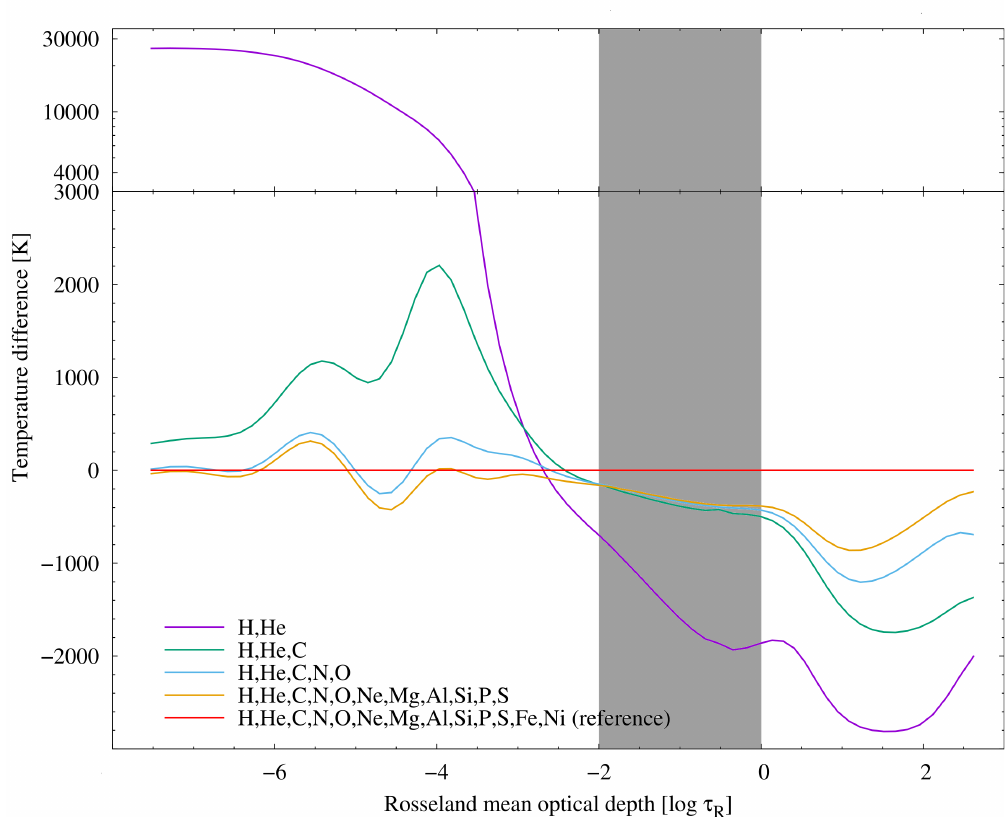
Figure 1. Temperature stratification of different NLTE atmospheres. The atmosphere containing iron and nickel was used as a reference point. The region of line formation is marked by the gray bar.